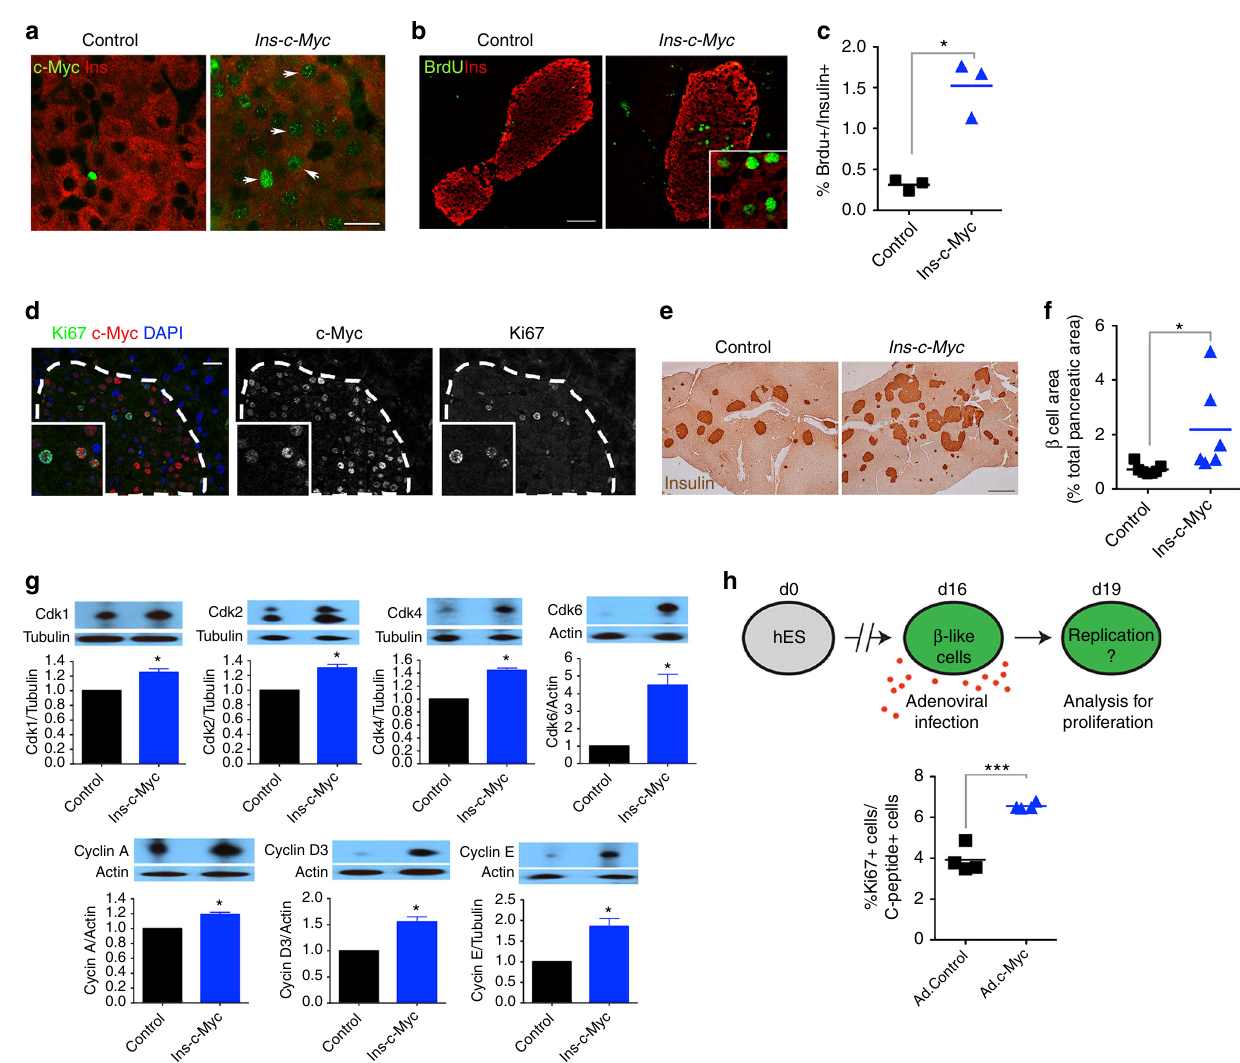
Fig. 2 c-Myc stabilization increases β -cell replication. a Nuclear accumulation of c-Myc (green) in transgenic β cells (Insulin, red). Scale bar, 15 μ m. Image shown is representative of at least three biological replicates. b BrdU (green) staining in Ins-c-Myc β cells (Insulin, red). Scale bar, 50 μ m. c Quanti fi cation of BrdU incorporation in Ins-c-Myc animals ( n = 3) as compared to controls ( n = 3). * p < 0.05, Student ’ s t test. d c-Myc expressing β cells co-stained with Ki67 in transgenic mice. Scale bar, 20 μ m. Insulin staining ( e ) and islet mass quanti fi cation ( f ) in Ins-c-Myc mice ( n = 6) as compared to controls ( n = 7). Scale bar, 100 μ m. * p < 0.05, Student ’ s t test. g Quanti fi cation of the seven signature proteins in Ins-c-Myc islets. n = 3 per group, error bars indicate ± SD, * p < 0.05, Student ’ s t test. All animals were three months old and were not administered TAM. h Cartoon summarizing experimental approach to test the effect of c-Myc on proliferation of hESC-derived β -like cells. Adenoviral infection was used to deliver either control (Ad. Control) or c-Myc (Ad.c-Myc) to hESC-derived β -like cells, and Ki67 staining quanti fi ed. n = 4. *** p < 0.0005, Student ’ s t